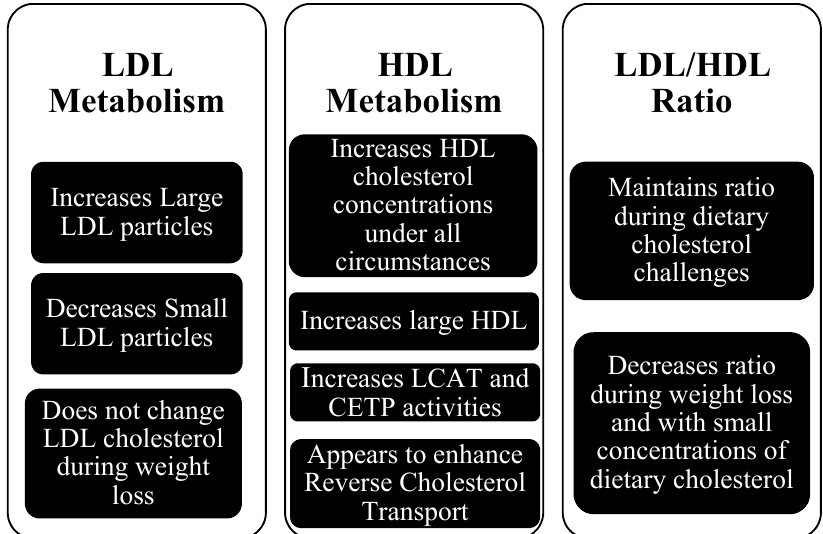
LDL Metabolism Increases Large LDL particles Decreases Small LDL particles Does not change LDL cholesterol during weight loss